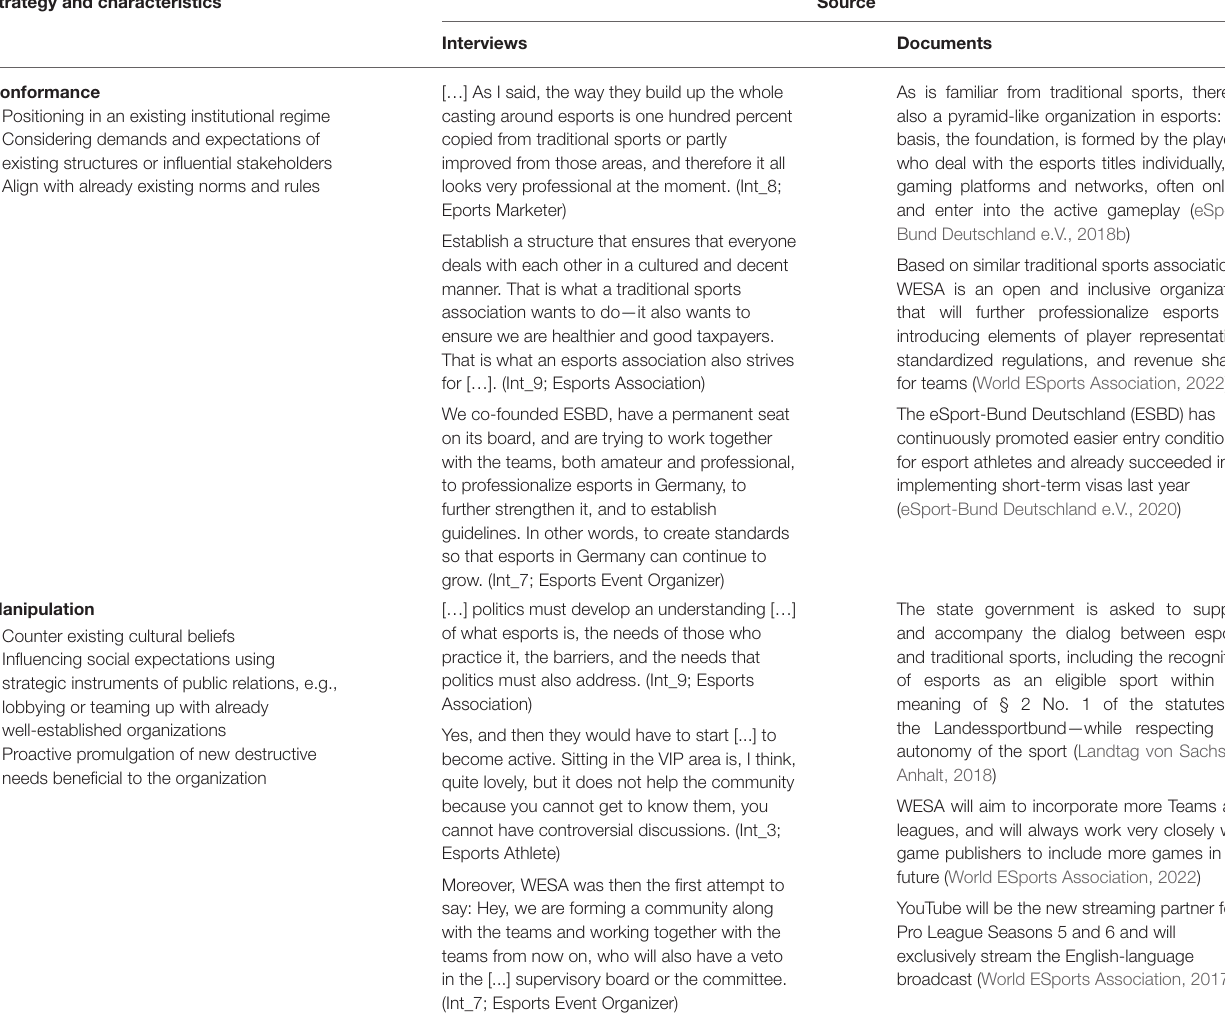
TABLE 4 | Selected exemplary interview statements and documents